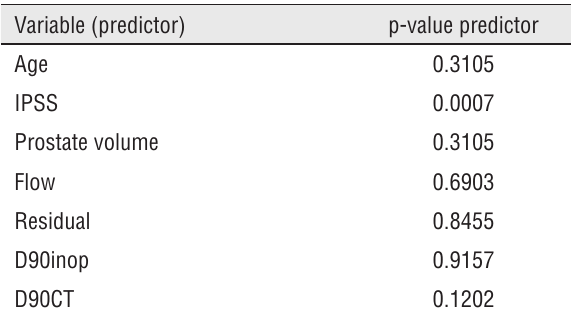
Table 3 - Logistic regression with retention after LDR as outcome variable. The only factor that was a significant cause for retention was a high IPSS